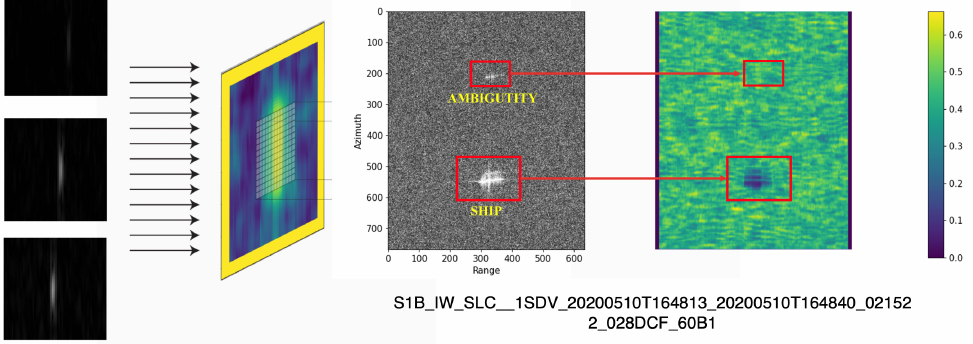
Figure 5. Visual representation of IE generation from three sub-looks ( left ) and its calculation for a Sentinel-1 product ( right ), in which a target and its ambiguity are highlighted.